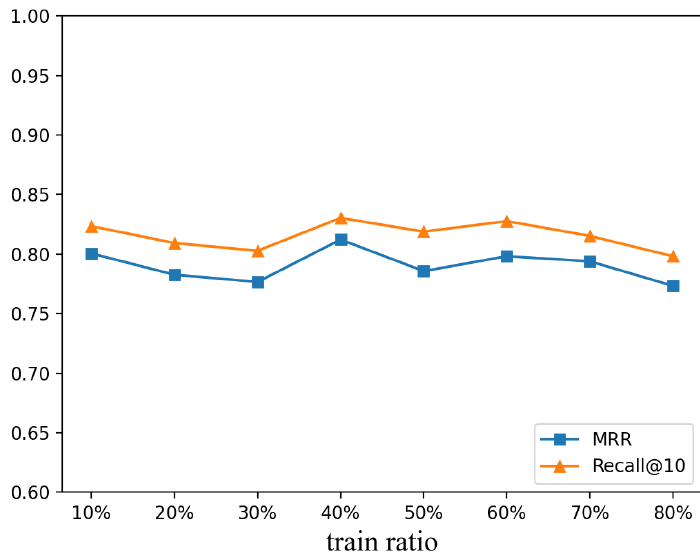
Figure 9. Percentage of training